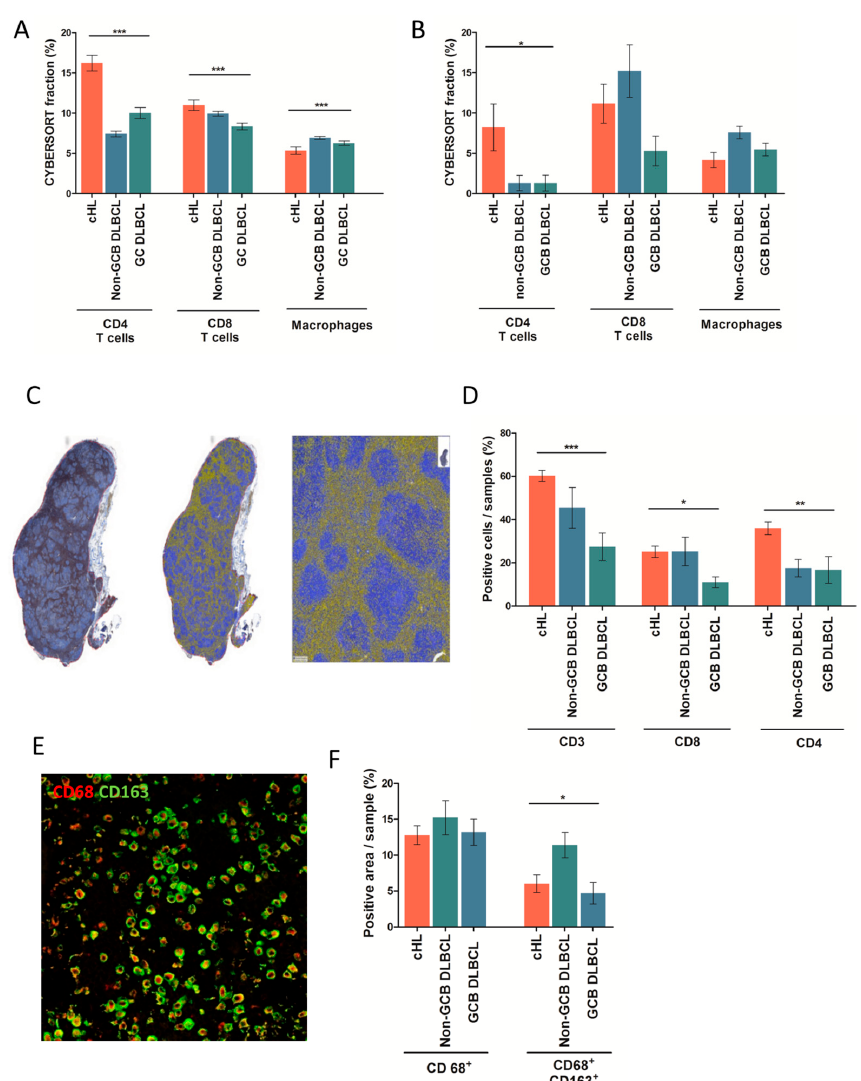
Figure 2. Immune subpopulation quantification based on microarray data and immunohistochemical studies in classical Hodgkin’s lymphoma and in diffuse large B-cell lymphoma. ( A ) T-cell and macrophage proportion (%) measured using the CIBERSORT deconvolution algorithm across cHL, non-GCB, and GCB DLBCL of public microarray data ( n = ~1000) (statistical analysis performed using a one-way Anova test). ( B ) T-cell and macrophage proportion (%) measured using the CIBERSORT deconvolution algorithm in cHL, non-GCB, and GCB DLBCL microarray data from our own cohort ( n = 28) (statistical analysis performed using a one-way Anova test). ( C ) Snapshot of automatic image analysis of CD3 staining using Definiens, Tissue Studio software. Example of IHC anti-CD3 on cHL lymph node (left panel; original magnification ×10). Example of quantification of CD3 + cells (yellow) and CD3 − cells (blue) (middle panel; original magnification ×10 and right panel; original magnification ×150). ( D ) Scoring based on IHC analysis of CD3 + T-cells, CD4 + T-cells, and CD8 + T-cells in cHL, non-GCB DLBCL, and GCB DLBCL samples from our cohort ( n = 28) (statistical analysis performed using a one-way Anova test). ( E ) Representative staining of CD68+ (red) and CD163+ (green) macrophages in cHL lymph node (original magnification ×200) (statistical analysis as performed using a one-way Anova test). ( F ) Scoring of fluorescence intensity of CD68 and CD163 staining in cHL, non-GCB DLBCL, and GCB DLBCL samples from our cohort ( n = 28) (statistical analysis was performed using a one-way Anova test). (* p < 0.05, ** p ≤ 0.01, *** p ≤ 0.001).